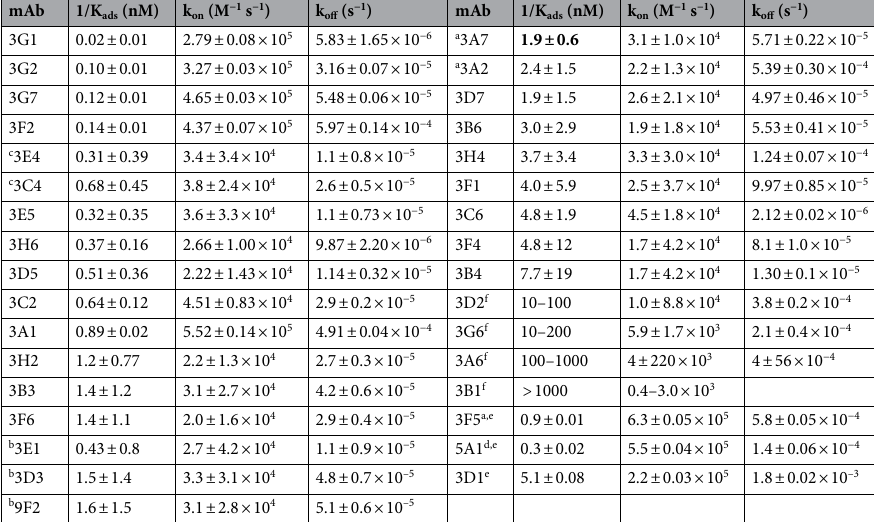
Table 1. Binding parameters of selected antibodies. Kinetic and thermodynamic parameters for binding of soluble spike ectodomain protein to antibodies immobilized by capture on anti-mouse Fc-coated biolayer interferometry sensor chips (ForteBio Octet). a Identical amino acid sequences (see Fig. 3a,b), so measured avidity treated as average (approx. 1.7 nM). b Identical amino acid sequences, so measured avidity treated as average (approx. 1.2 nM). c Identical amino acid sequences, so measured avidity treated as average (approx. 0.5 nM). d From series 3 immunization; all other mAbs from series 2. e Data acquired with supernatant from cultured hybridoma cells. f Poor fit of data to binding isotherm, binding constant estimated using both pure mAb and